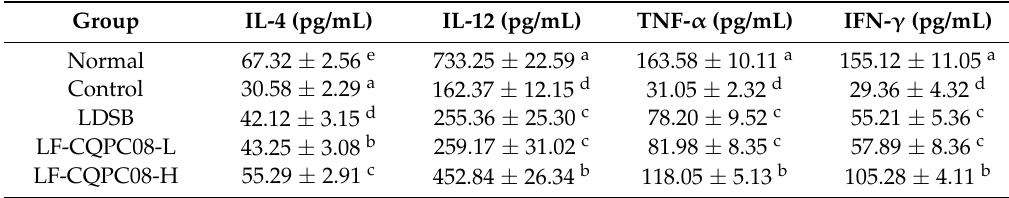
Values presented are the mean ± standard deviation (N = 10/group). a–d Mean values with different letters in the same row are significantly different ( p < 0.05) according to Duncan’s multiple-range test. LDSB: mice treated